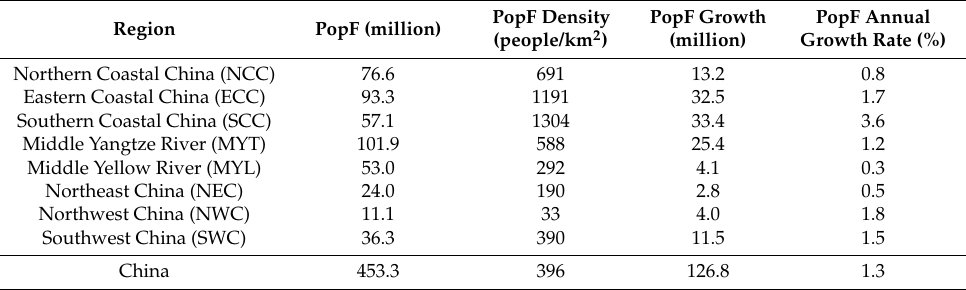
Table 1. Population in the floodplain (PopF) and its density in 2015 and growth during 1990–2015 in different regions of China.